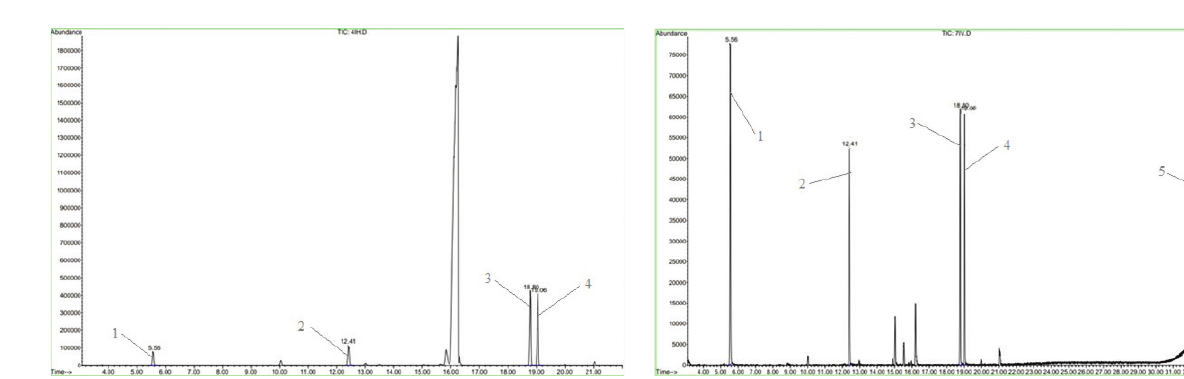
Figure 5. Chromatogram of carbohydrates formed as a result of enzymatic hydrolysis in the herbal mixture No. 7 (1 – arabinose, internal standard; 2 – glucose; 3–4 – fructose).